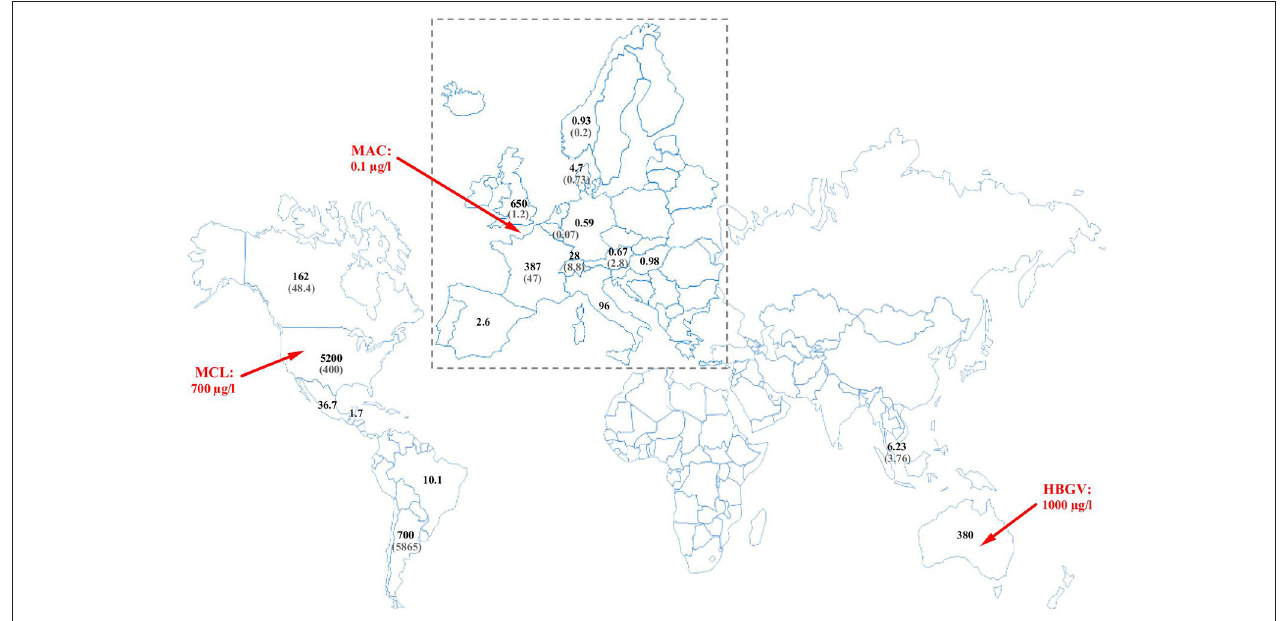
FIGURE 4 | Maximal residue levels ( µ g/l) of glyphosate ( black ) and AMPA ( gray in parentheses ) in surface and ground water reported worldwide. Corresponding permitted levels in drinking water are indicated in red e.g., maximum admissible concentration (MAC) in the European Union, maximum contaminant level (MCL) in the US and health-based guideline value (HBGV) in